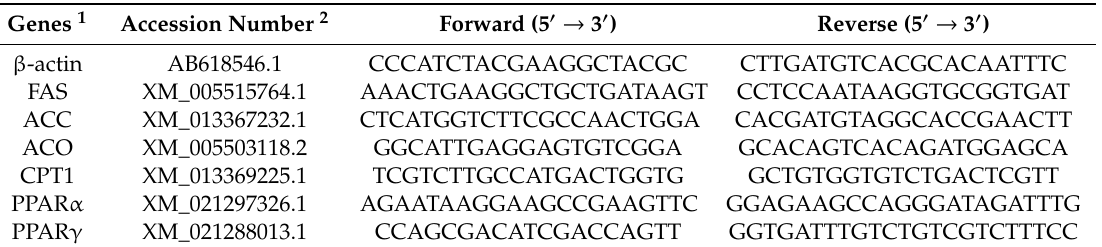
Table 2. Primers used for quantitative real-time PCR analyses of gene expression in domestic pigeon